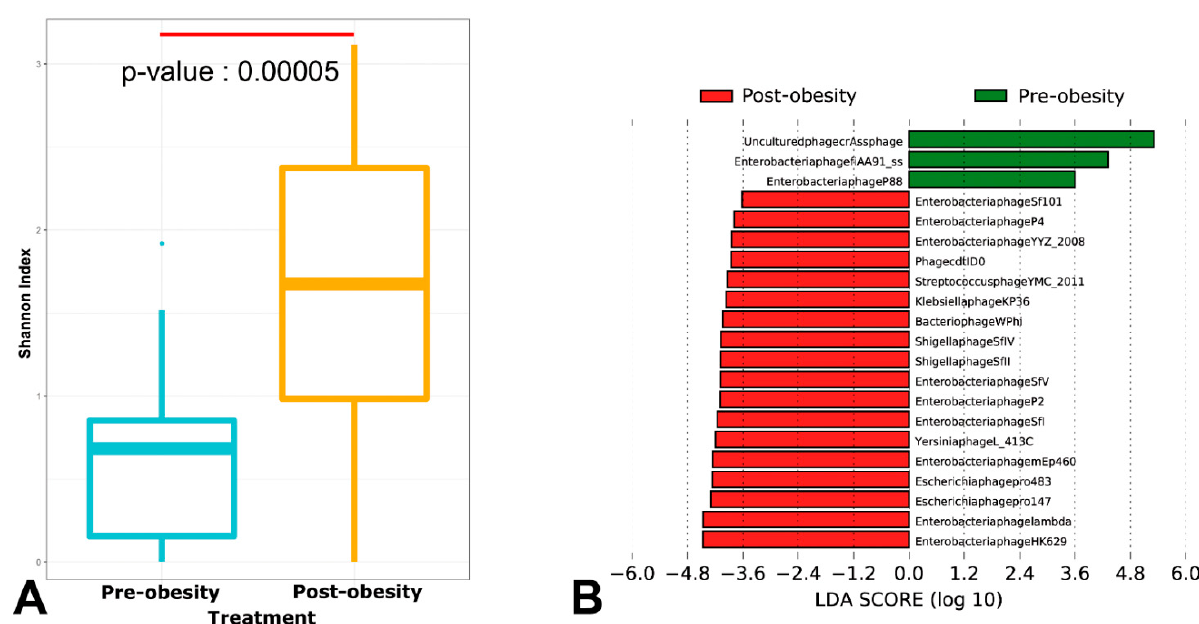
Figure 1. Alpha diversity metric measured by Shannon index and viral biomarkers identified in pre- and post-obesity groups. In ( A ), light blue boxplot indicates the index level of the pre-obesity group, and yellow represents the post-obesity treatment. The p -value indicates the statistical significance. In ( B ), the viral biomarkers presented in pre- (green) and post-obesity (red) intervention groups are shown.